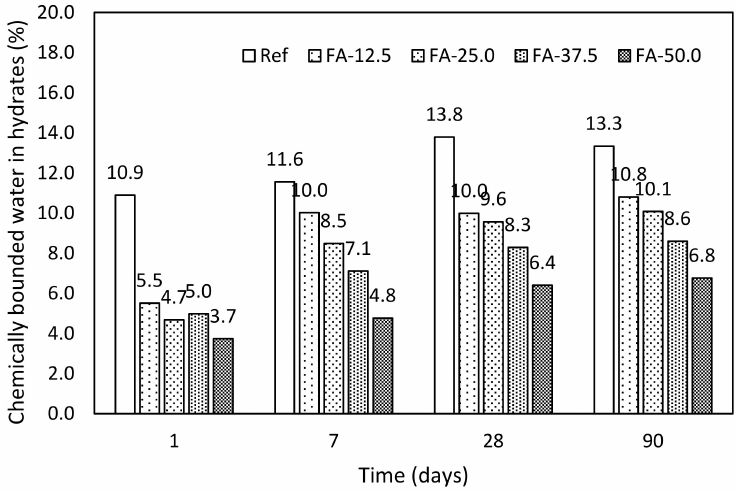
Figure 4. Chemically bounded water in hydrates—pastes with fly